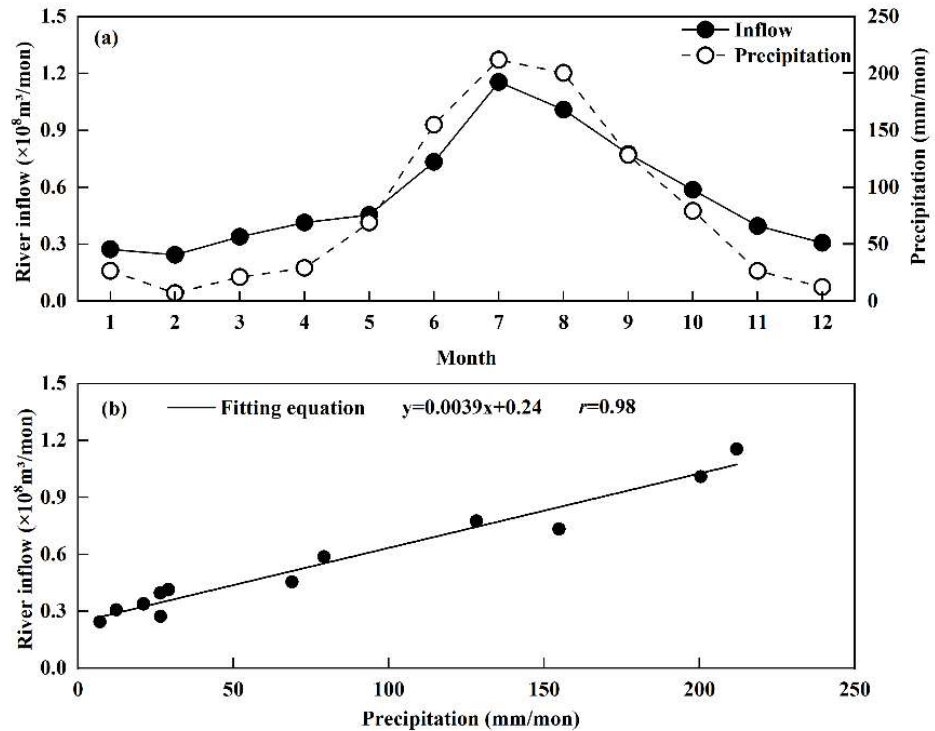
Figure 6. Intra-annual variations of total river inflow and precipitation (a) and their fitting relation- ship (b) for 2007 -